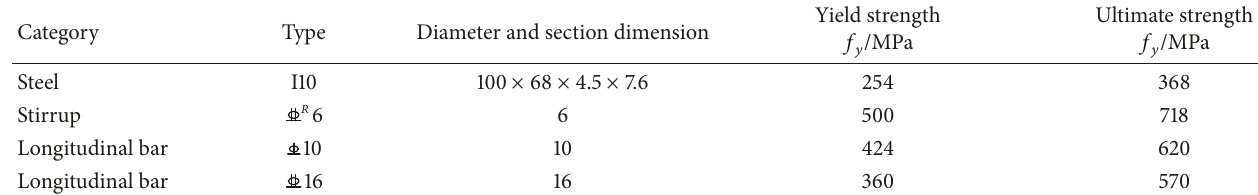
Table 3: Steel material properties.